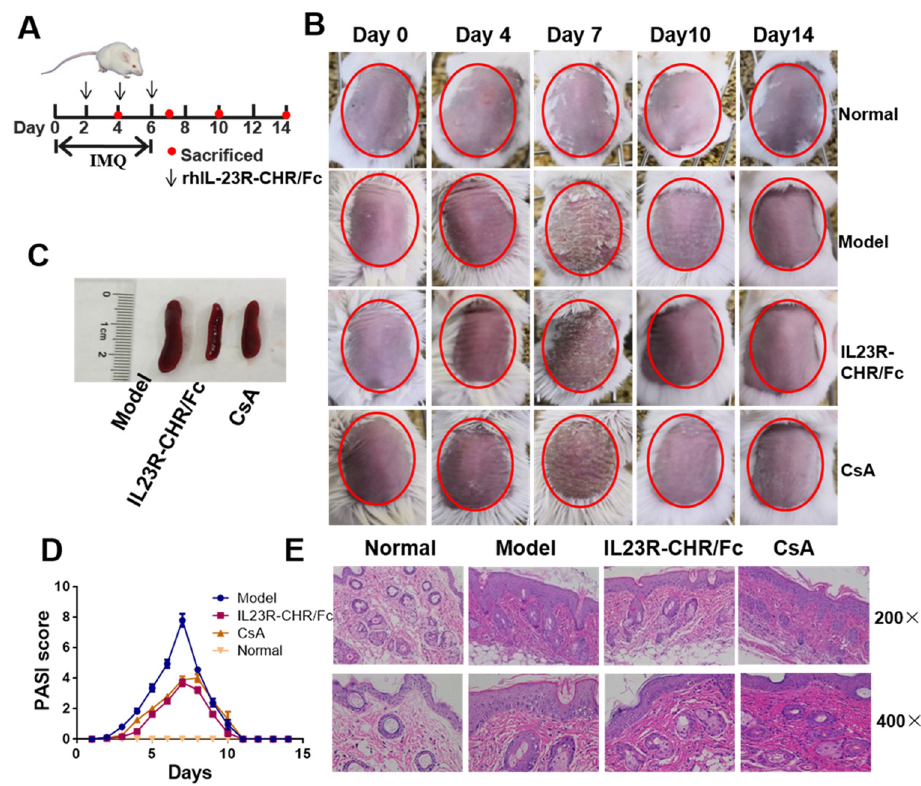
Figure 3. rhIL-23R-CHR / Fc ameliorated skin inflammation in an imiquimod (IMQ)-induced psoriasis-like model. ( A ) Schematic diagram of intravenous administration of rhIL23R-CHR / Fc on days 2, 4 and 6 during the application of IMQ. Three mice in each group were sacrificed on days 4, 7, 10 and 14 to conduct experiments. The normal group did not receive IMQ as a negative control. Cyclosporin A (CsA), an immunosuppressive agent commonly used in the clinical therapy for autoimmune diseases, was used in the treatment of psoriasis at 1.5 mg / kg as a positive control. ( B ) Phenotypic presentation of lesional skin from mice. ( C ) The size of spleens of mice. ( D ) Mice skin Psoriasis Area and Severity Index (PASI) scores. ( E ) Haematoxylin and eosin staining of lesional skin obtained from normal mice or mice treated with IMQ, CsA or rhIL-23R-CHR / Fc at day 7 (200×, 400×).